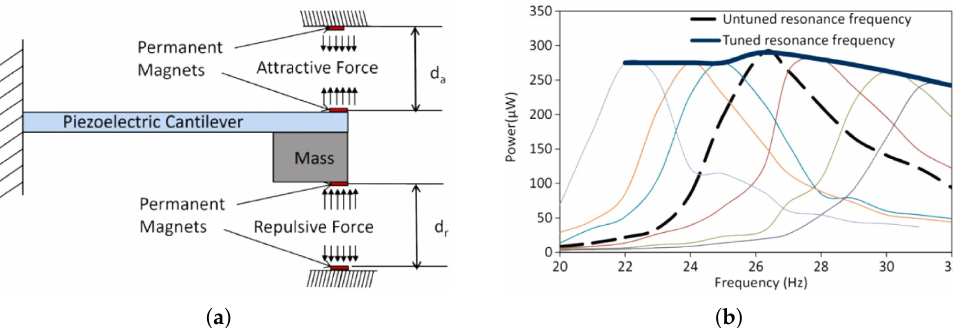
Figure 23. Frequency tunable harvester with geometrical tuning proposed by Challa et al. [88] (figure taken from [89] with permission); ( a ) schematic design of the proposed harvester; ( b ) frequency response for different